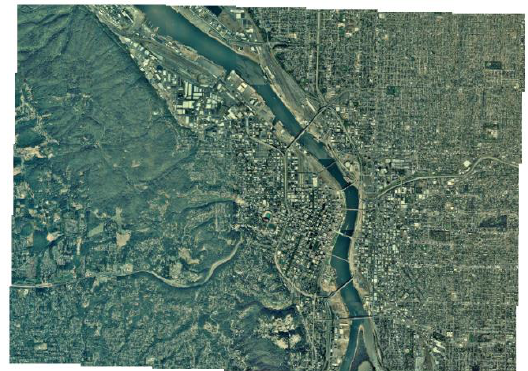
Fig.3.1 Color balance result: Single Color Target Model.